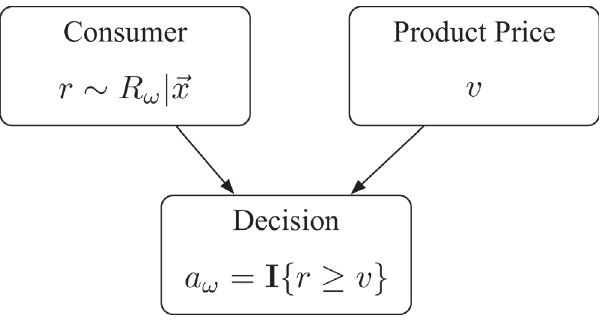
Fig 4. How consumers reach a purchasing decision when offered product ω at price v